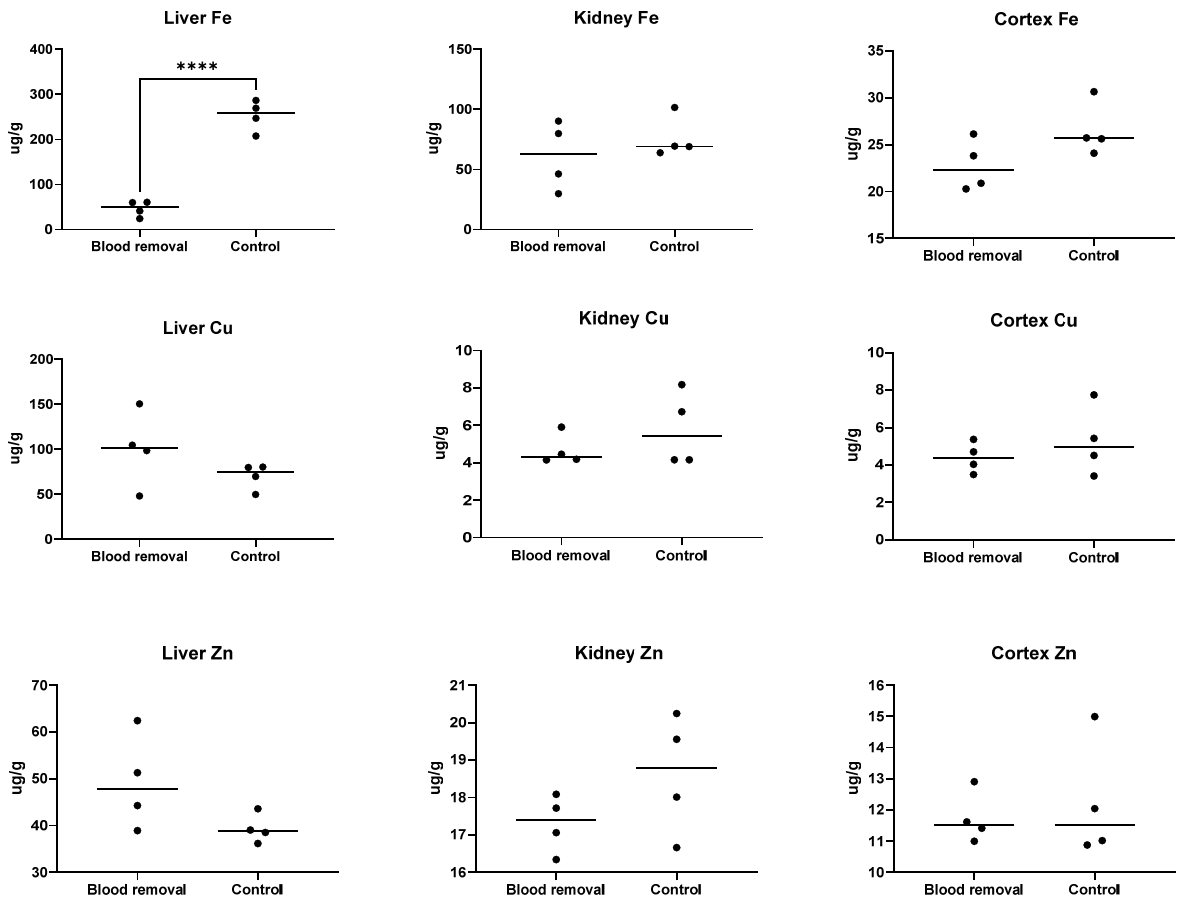
Figure 5. Tissue concentrations of iron (Fe), copper (Cu) and zinc (Zn) in sows from trial I. **** indicates a highly significant difference between groups ( p < 0.0001). Sows from the blood removal group had been subjected to blood removal procedures from mid gestation and received an iron-reduced-diet.